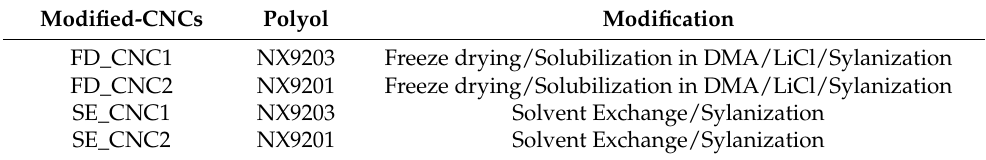
Table 1. Description of modified CNCs.